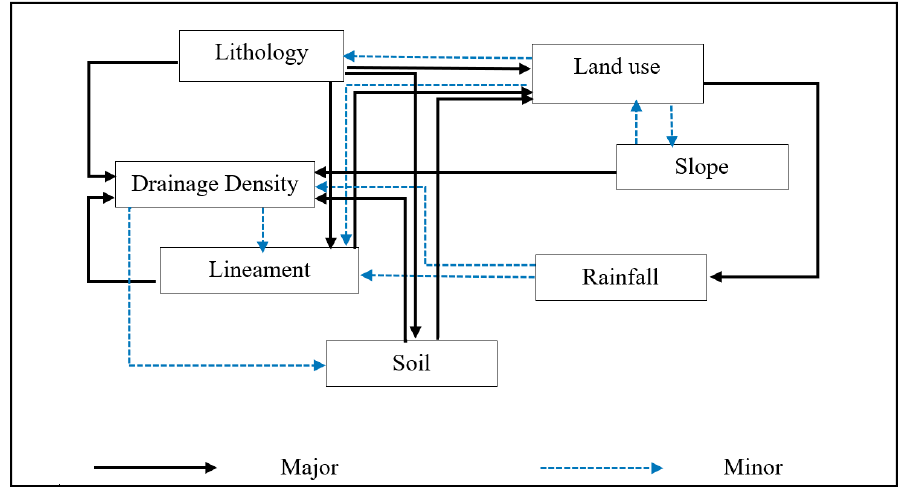
Figure 6. Interactive influence of factors for groundwater recharge potential. Table 2. The values of major, minor, relative rates, and proposed weights of the influencing factors.